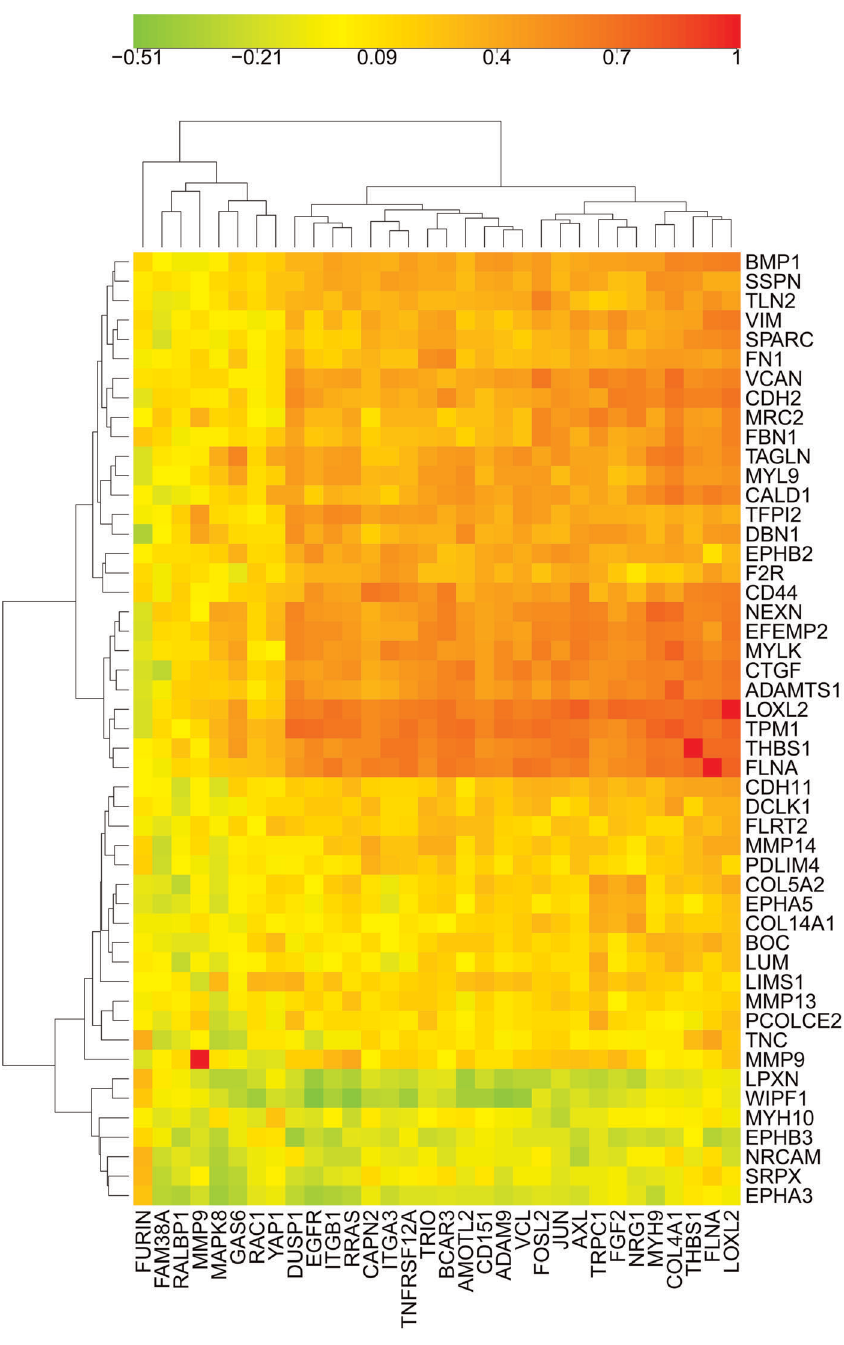
Figure 13. Relationship between cell migration-related genes in this report with EMT-upregulated genes reported by Thomson et al [ 87 ] : Clustered image map (CIM) of the cell migration-related genes (horizontal) listed in Figure 3 versus the EMT-upregulated genes (vertical) reported by Thomson et al (reddish color in their Figure 3). This CIM depicts the expression correlations between the respective genes in the NCI-60 cell line